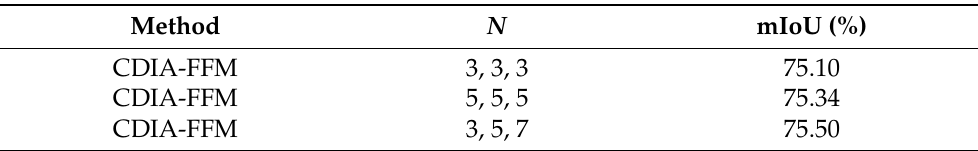
Table 3. Ablation experiments on the PASCAL VOC 2012 data set. The parameter N represents the size of the convolution kernel in the cross-dimensional interactive attention decoding module. There are three fusion modules in the network.